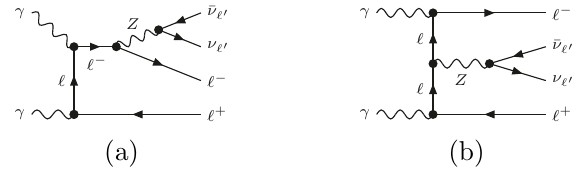
Figure 4 . Sample of photon-induced Born diagrams contributing to 2 ‘ 2 (cid:23) (cid:12)nal states only in the same lepton-(cid:13)avour case, both for ‘ 0 = ‘ or ‘ 0 = ‘ . Only single-resonant diagrams contribute. 6 relevance varies signi(cid:12)cantly between the channels. Photon-induced contributions to the DF channel are dominated by (cid:13)(cid:13) W + W (cid:0) e + (cid:22) (cid:0) (cid:23) e (cid:22) (cid:23) (cid:22) topologies, which are ! !